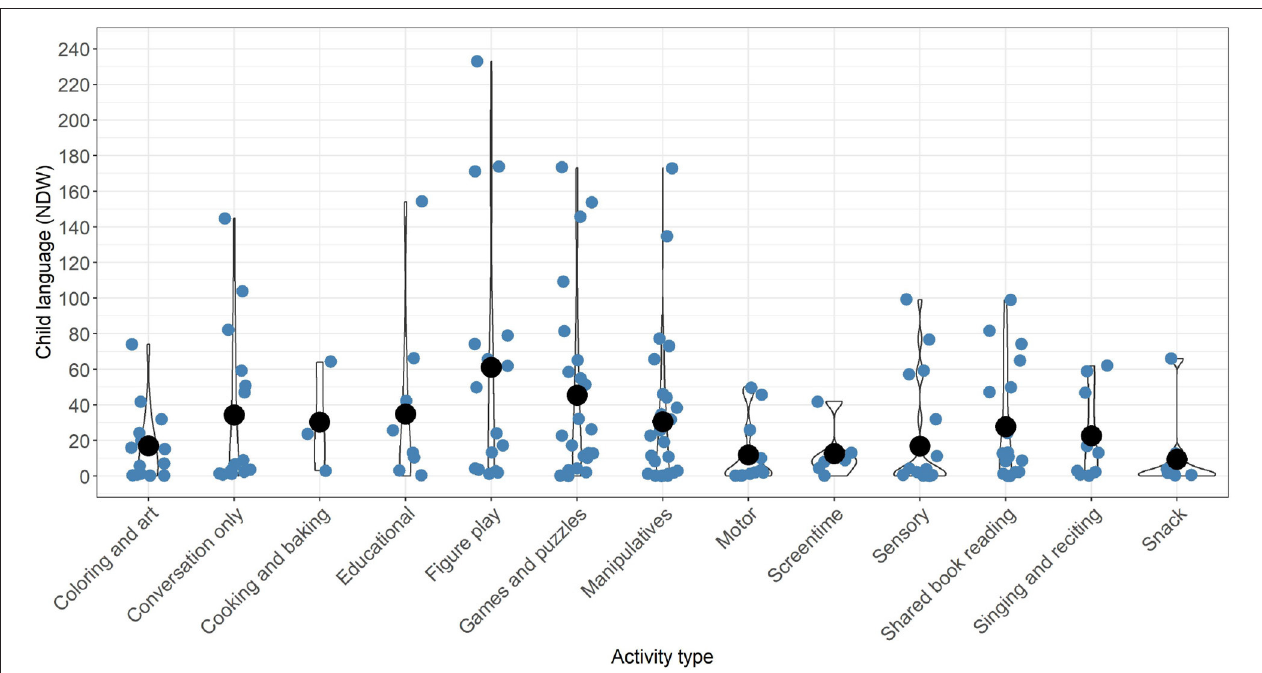
FIGURE 1 | Activity types and child spoken language level.